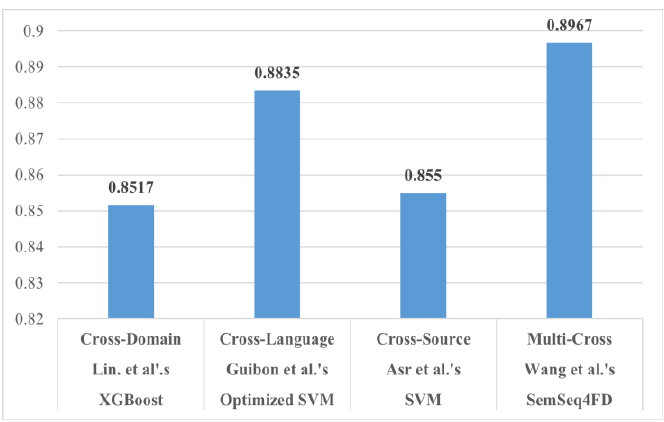
Figure 2. Best F1-Score Performance per Cross-Category .